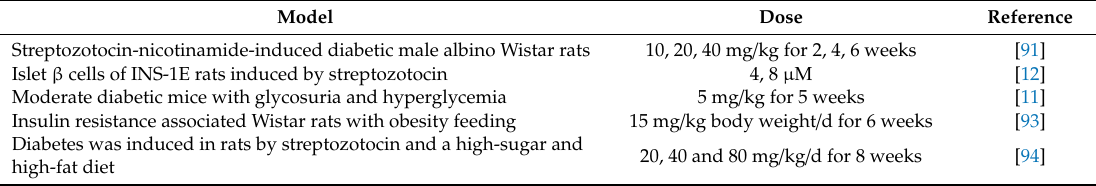
Table 5. Model and dose of hypoglycemic activity of